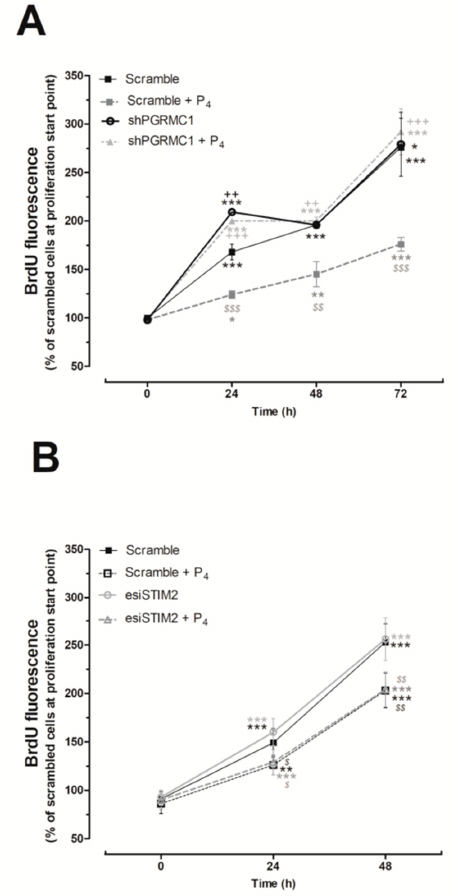
Figure 7. Effect of silencing the progesterone receptor membrane component 1 (PGRMC1) and the stromal interaction molecule 2 (STIM2) in the proliferation of MDA-MB-231 cells. MDA-MB-231 cells were transfected for 48 h with either small hairpin siRNA against PGRMC1 (shPGRMC1) ( A ) or the respective empty vector ( A ; scramble), and alternatively, cells were transfected with either endoribonuclease-generated siRNA against STIM2 (esiSTIM2) ( B ) or siRNA for 48 h ( B ; scramble). Upon confirming the efficiency of the silencing protocol by Western blotting, the cells were seeded and allowed to proliferate in the absence or presence of progesterone (P 4 ; 1 μ M) . The proliferation rate was determined by analyzing the bromodeoxyuridine (BrdU) uptake by the cells for 2 h at 0, 24, 48, and 72 h from the beginning of the proliferation experiments. Graphs represent the average of the percentage ± Standard of the Mean (S.E.M.) of the BrdU fluorescence detected in the scrambled cells